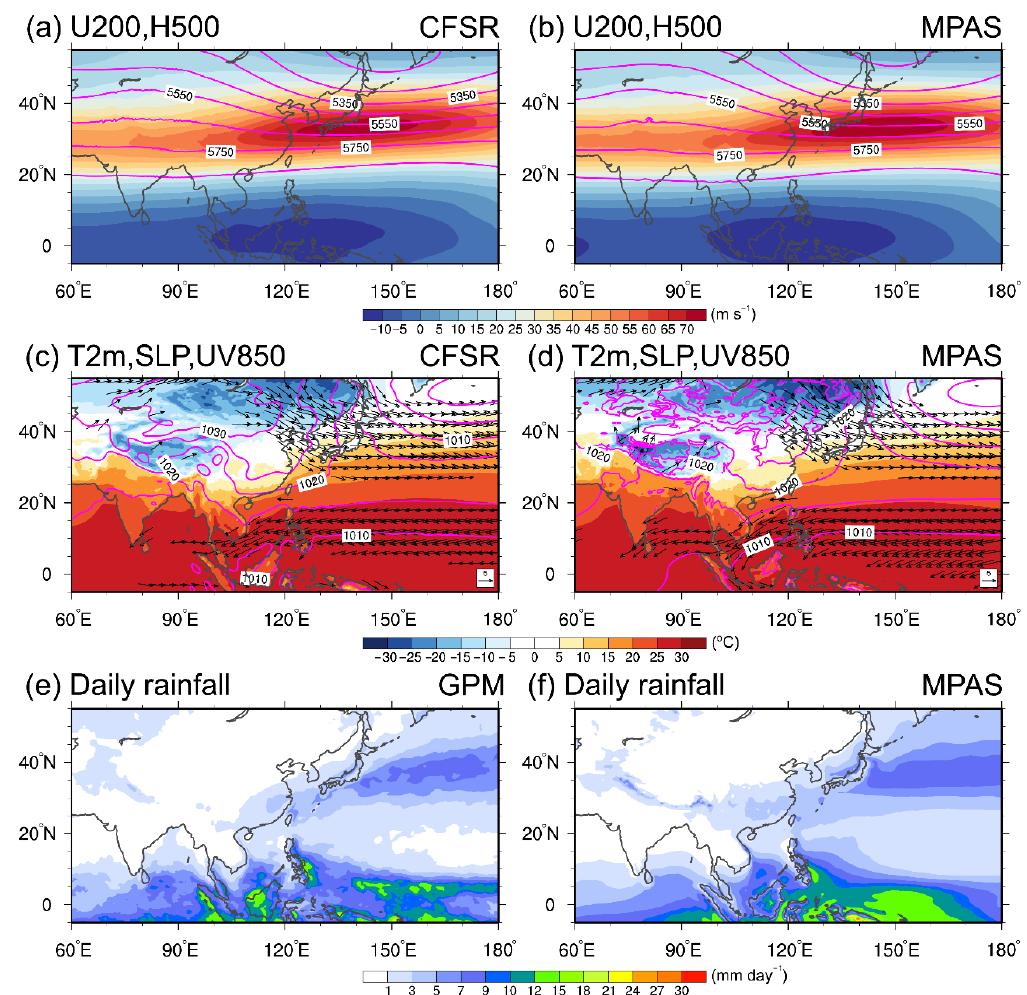
Figure 2. Climatological DJF mean over 2011 – 2020 for ( a , b ) 200-hPa zonal wind (shaded) and 500-hPa geopotential height (contours), ( c , d ) 2-m temperature (shaded), sea-level pressure (contours), and 850-hPa winds (vectors), ( e , f ) daily rainfall (shaded). CFS reanalysis and GPM-retrieved rainfall (simulations) are listed at left (right) column.